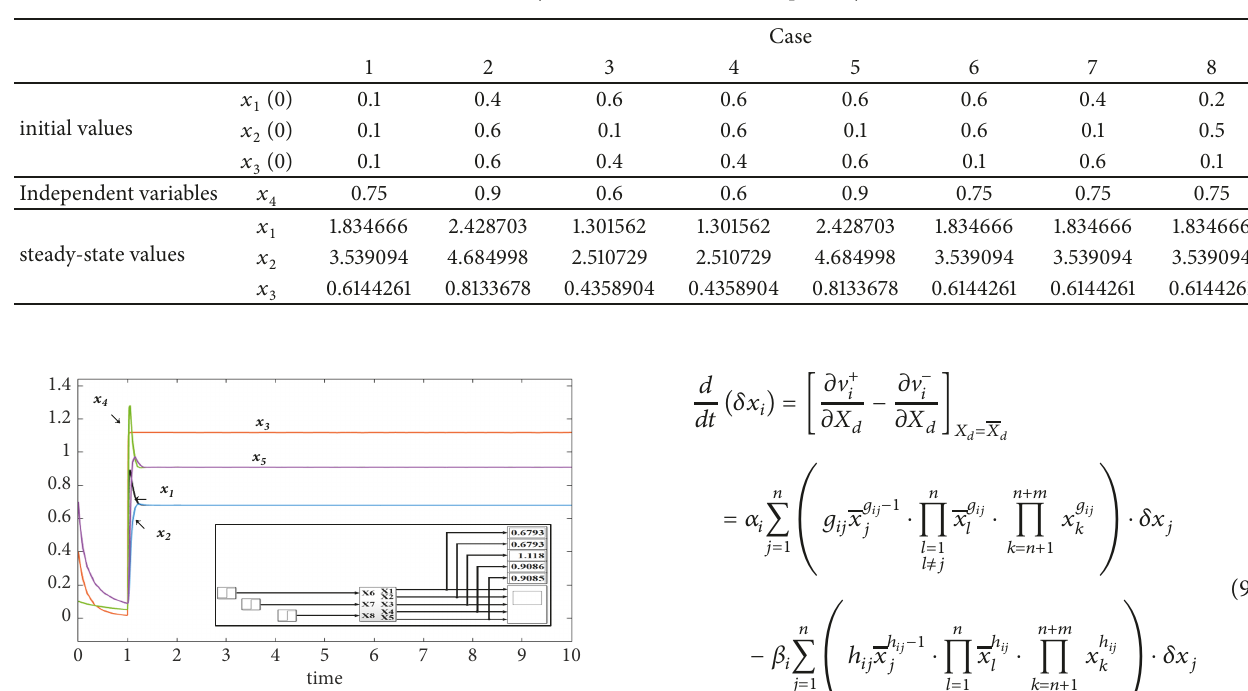
Table 2: Steady state values of the cascade pathway.